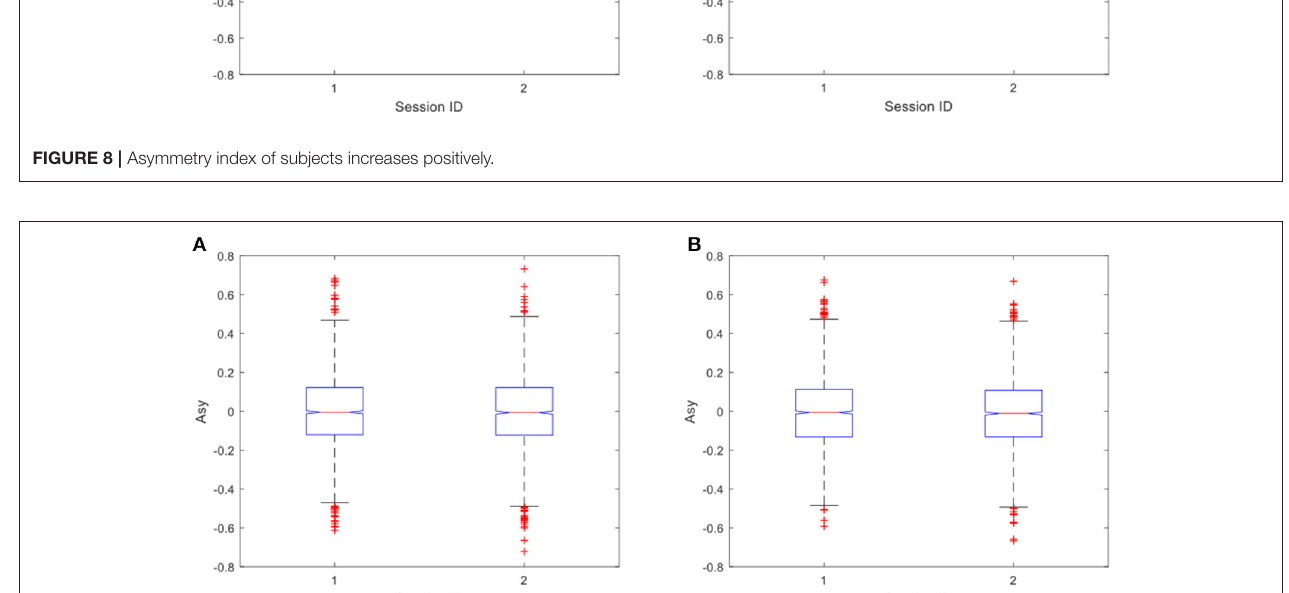
FIGURE 9 | (A) Difference in asymmetry index for negative stimulations ( p = 0.627) in the control group. (B) Difference in asymmetry index for positive stimulations ( p = 0.4666) in the control group.